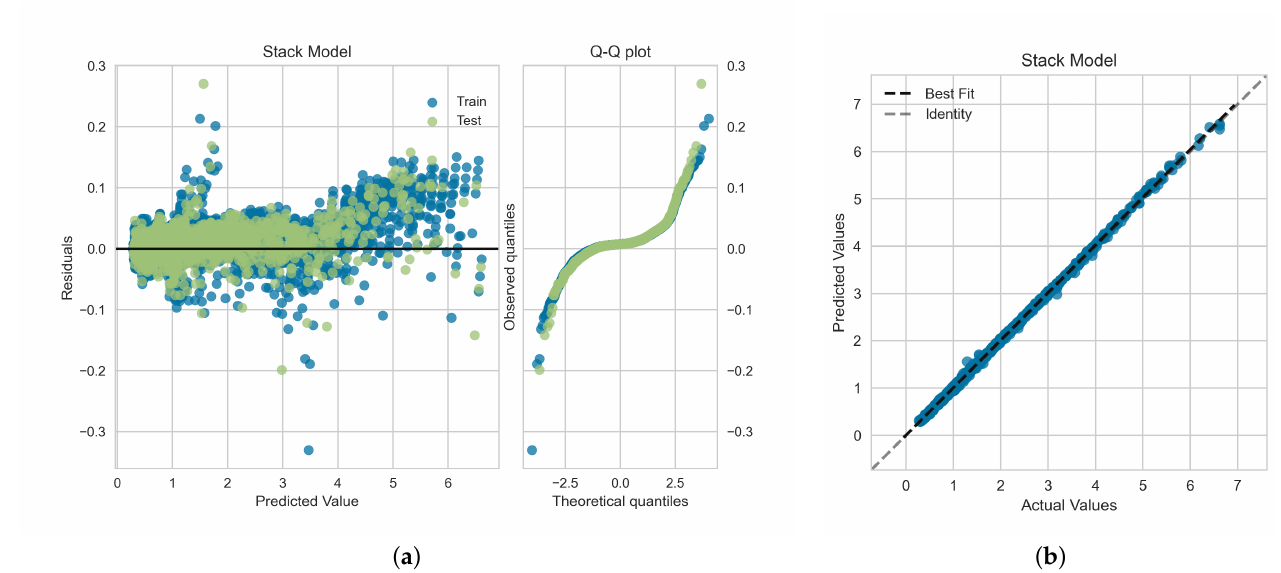
Figure 14. ( a ) Residuals and quantile-quantile (Q-Q) plots and ( b ) prediction error plot obtained for the meta-model shown in Figure 13 and trained, validated and tested on SMOTE-set . The statistical measures are reported in Table 9.